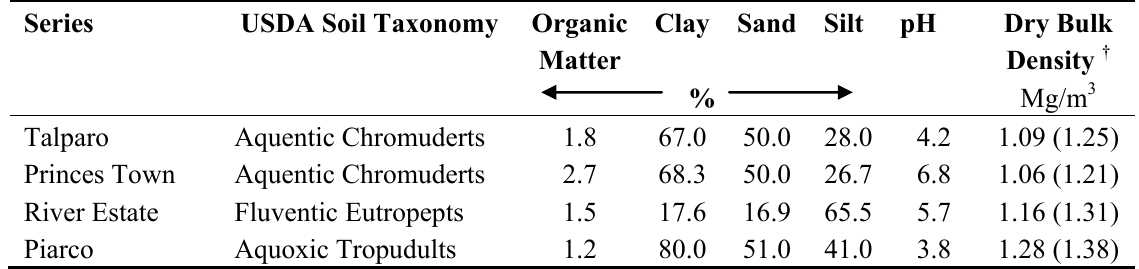
Table 1. Selected properties of study